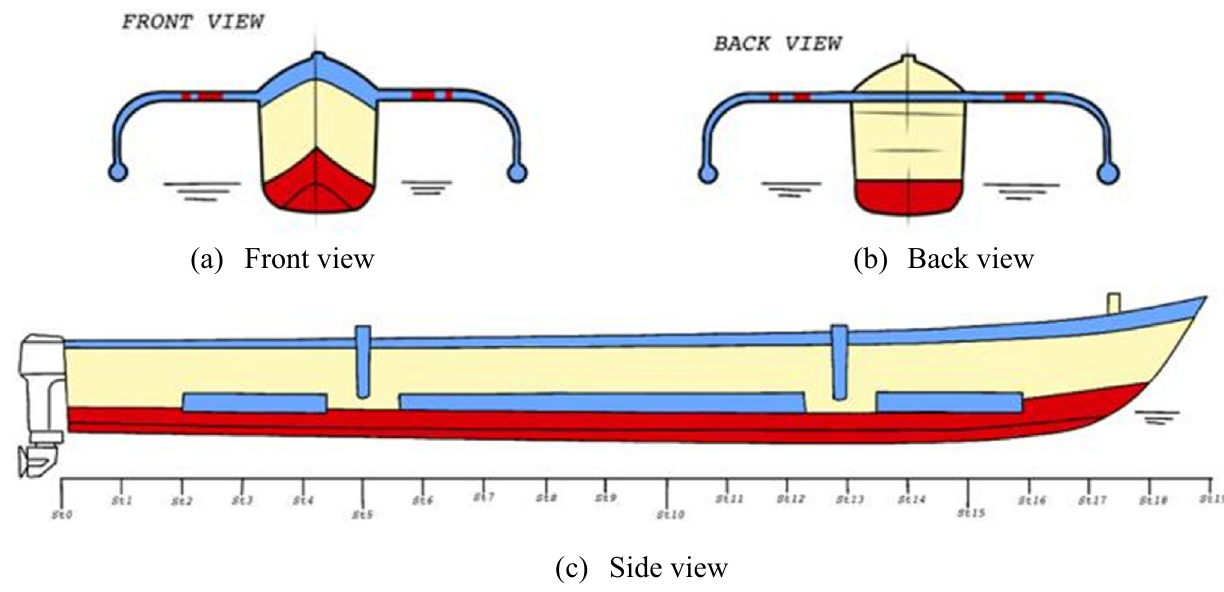
Fig. 1 Small boat design without long mast and tent cover. a front view; b back view; c side view